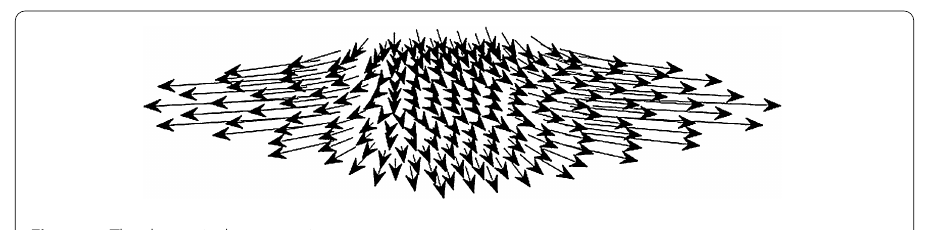
Figure 4 The theoretical ray mapping